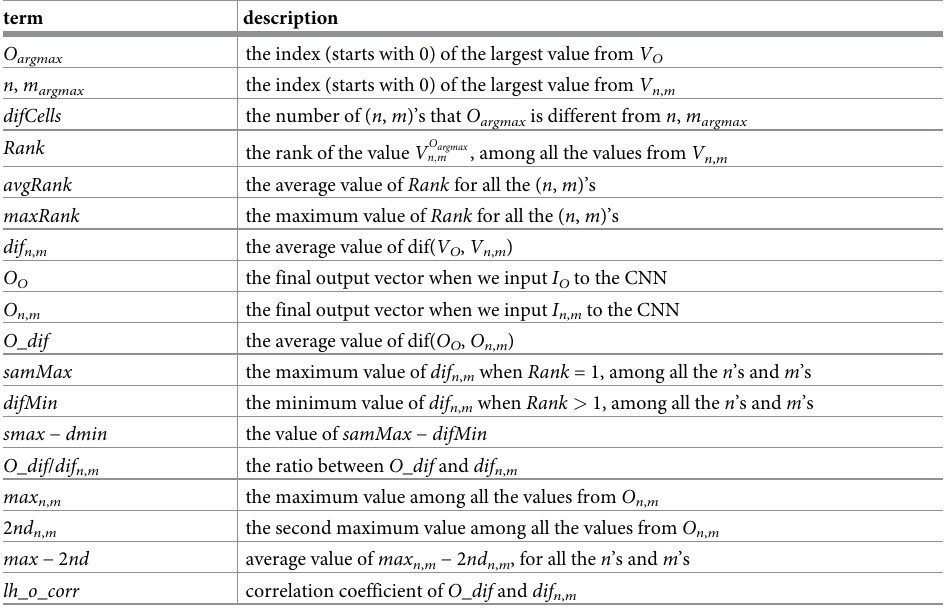
Table 4. Meanings of variables for experimental results.